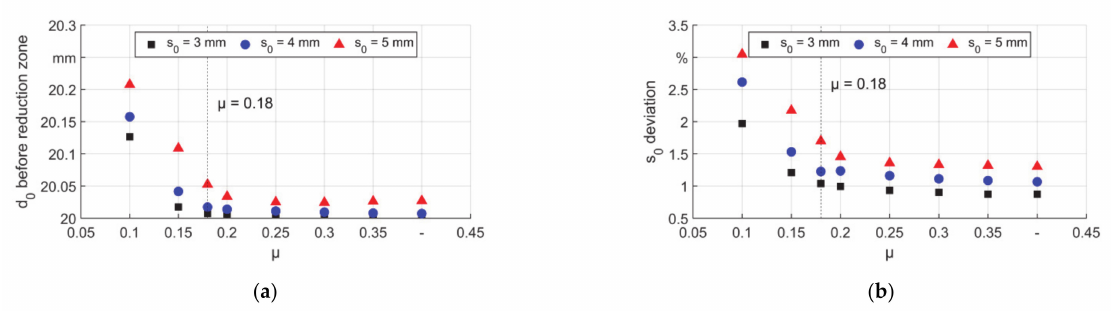
Figure 12. Geometrical information before material enters the reduction zone, ( a ) diameter and ( b ) thickness.